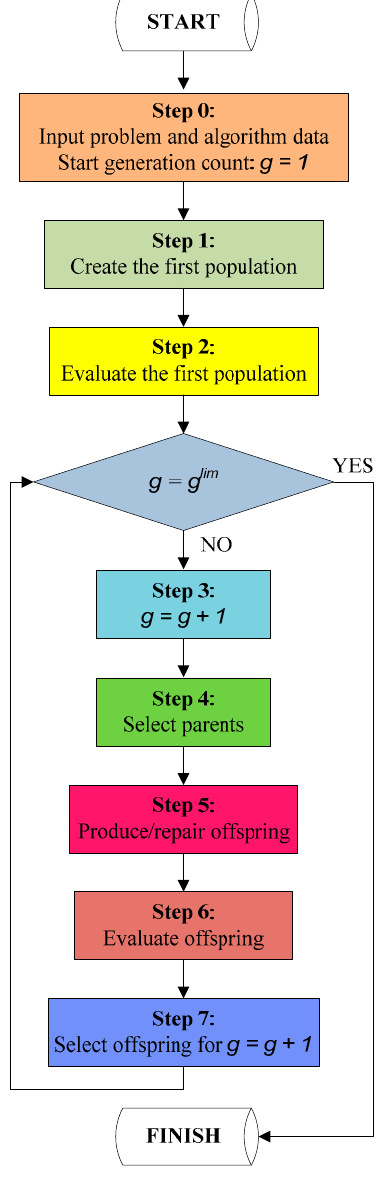
Figure 3. The main SAEA steps.